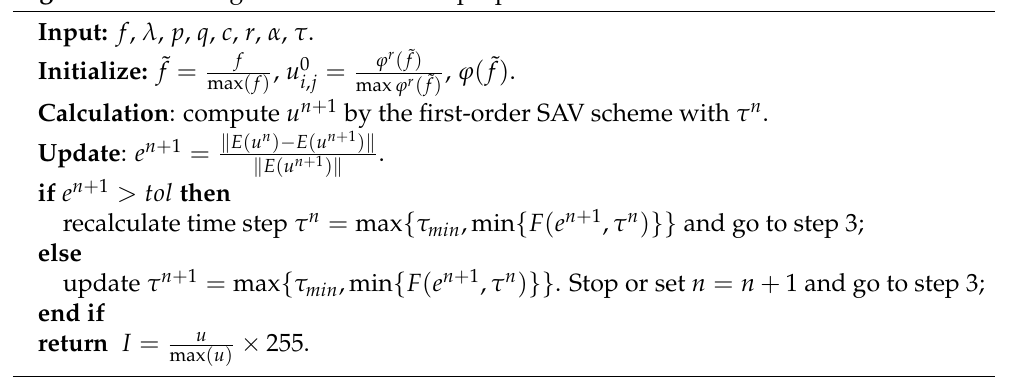
Algorithm 1 SAV algorithm to solve the proposed